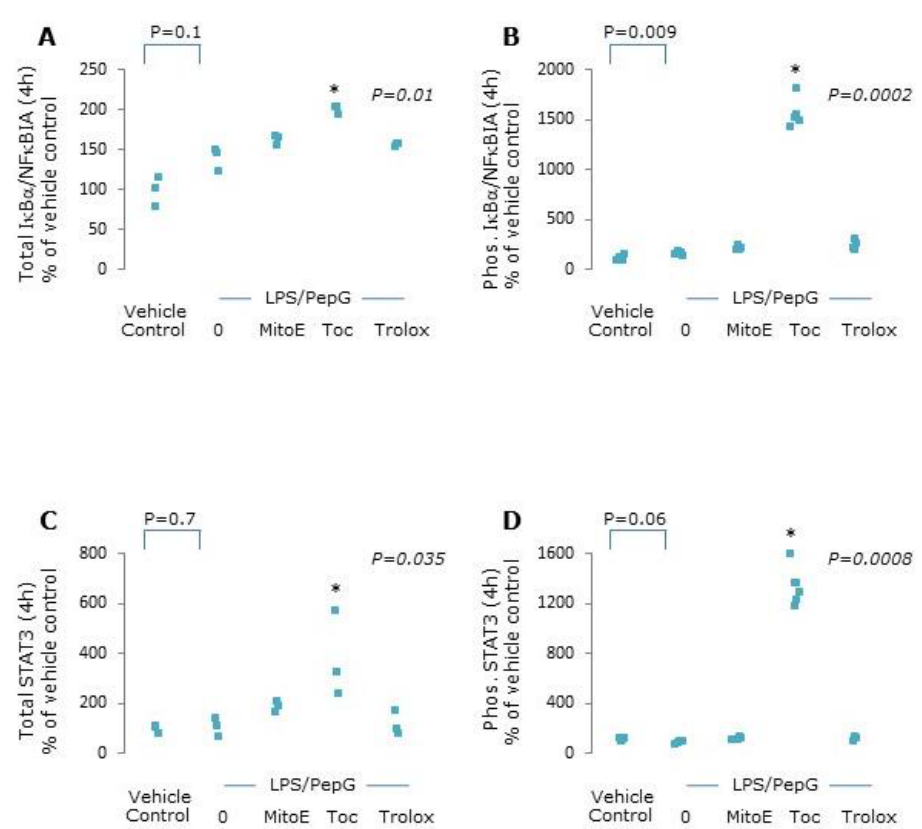
Figure 5. Total and phosphorylated IκBα and STAT3 expression . Endothelial cells were treated with vehicle control, lipopolysaccharide plus peptidoglycan (LPS/PepG) alone, or LPS/PepG plus 5 μM MitoVitE (MitoE), tocopherol (Toc) or Trolox for 4 h. ( A ) Total IκBα, ( B ) phosphorylated IκBα, ( C ) total STAT3 and ( D ) phosphorylated STAT3. Individual data points shown ( n = 3–6). P value in italics refers to Kruskal–Wallis across LPS/PepG treated groups, * = significantly higher than LPS/PepG alone ( p < 0.05). Table 1. Differential gene expression.